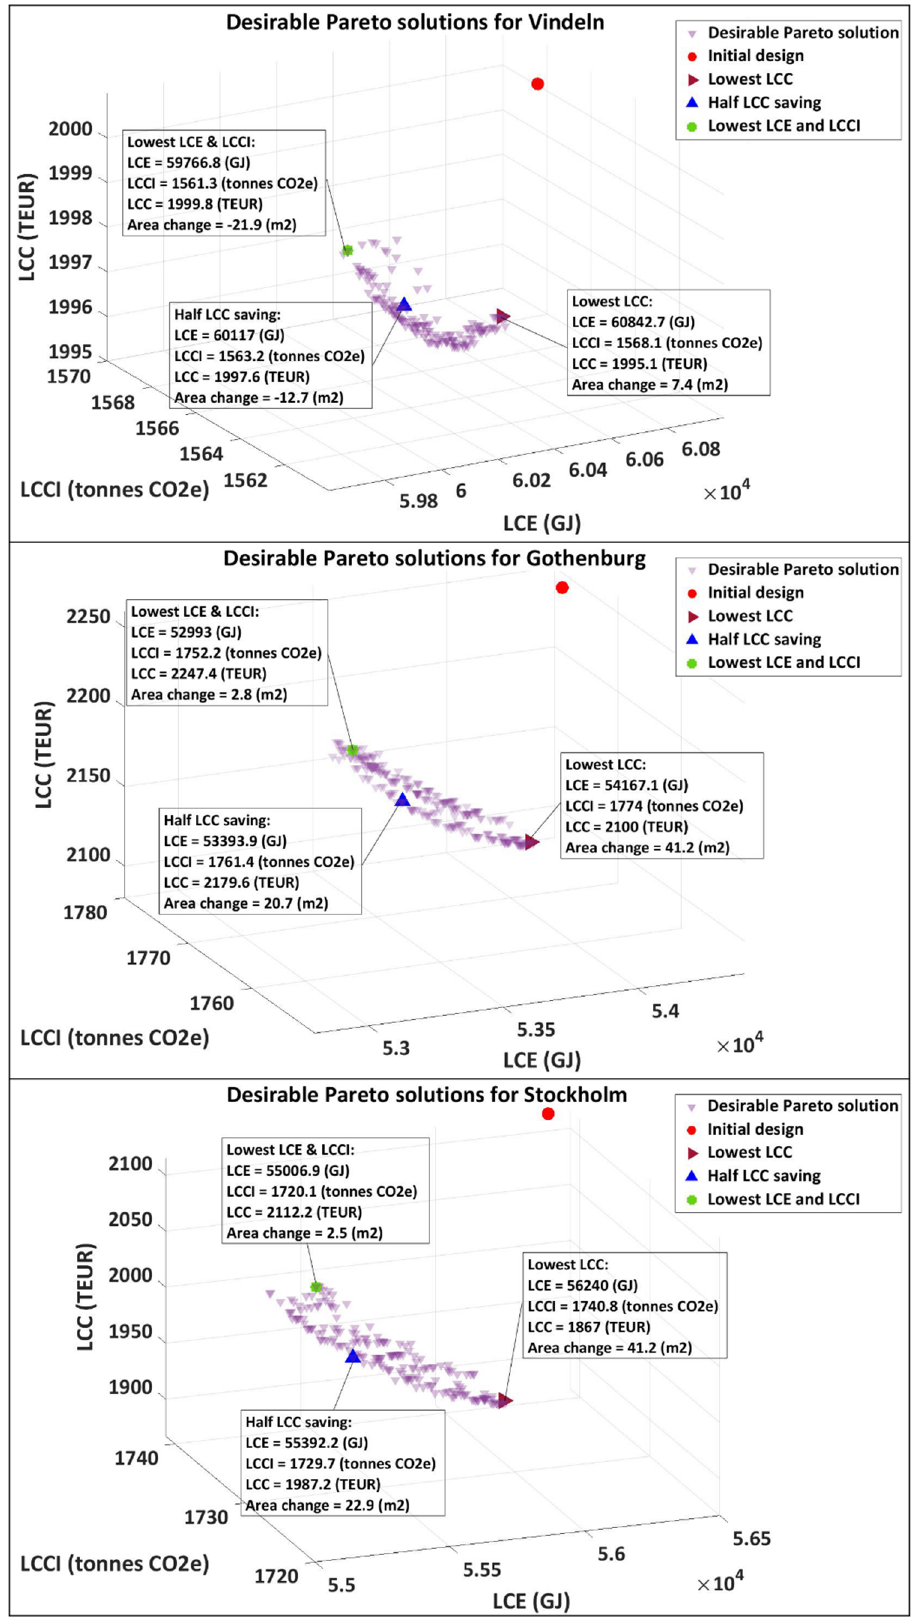
Figure 7. The life cycle energy, carbon impact, and cost values of Pareto solutions that outperform the initial design’s sustainability performance (referred as desirable Pareto solutions) in different locations. A colour print is recommended.